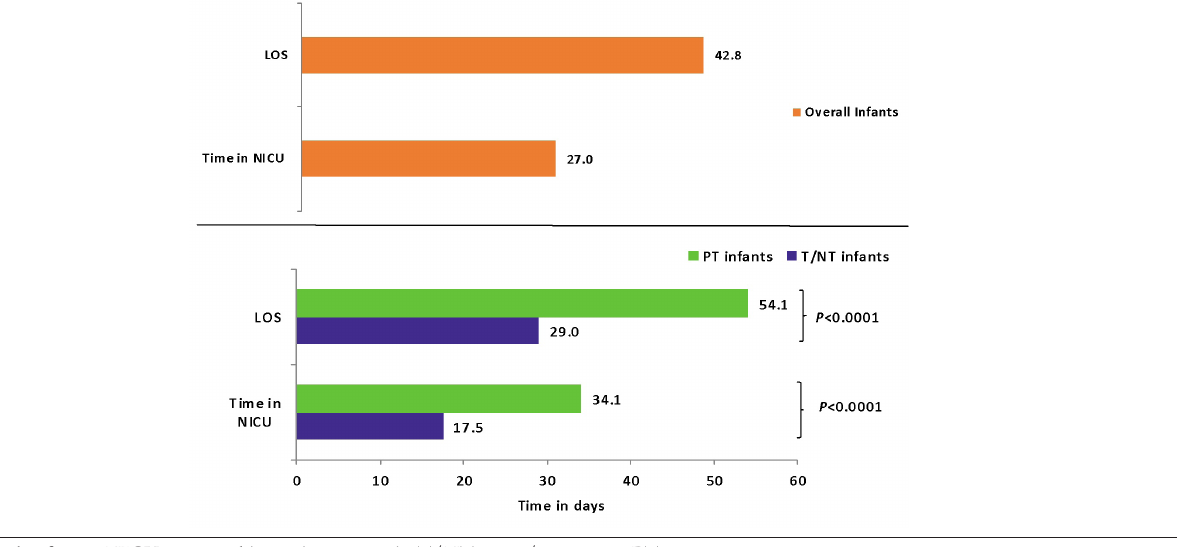
Figure 1. Health Care Resource Utilization Among Infants diagnosed with HRF/PPHN